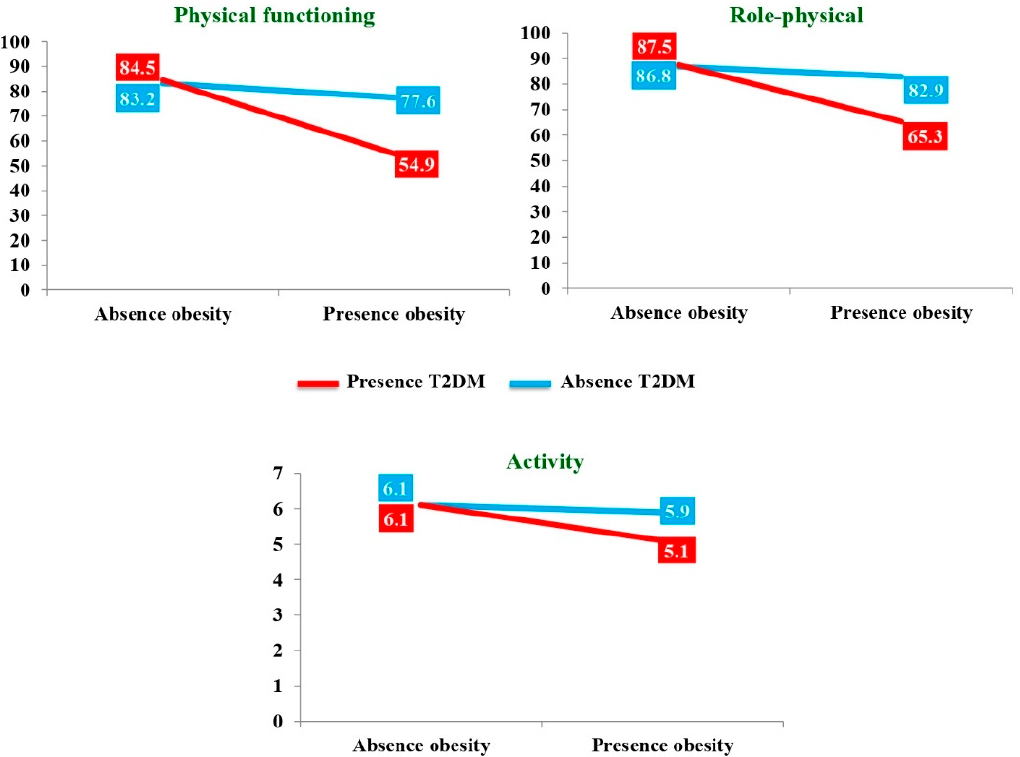
Figure 2. Interactive effects regarding physical functioning, role-physical and activity dimensions in patients with NAFLD.